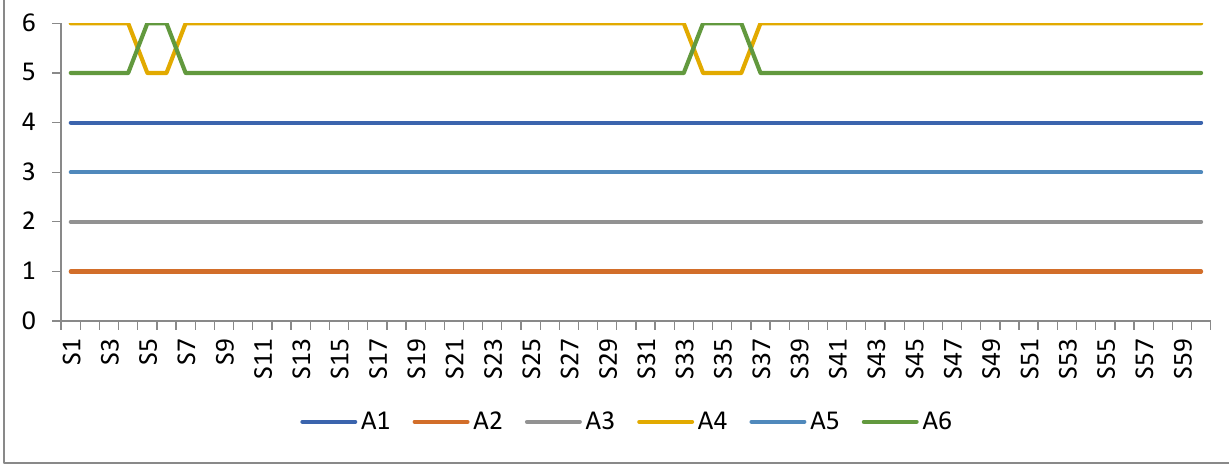
Figure 2. Results of the sensitivity analysis.